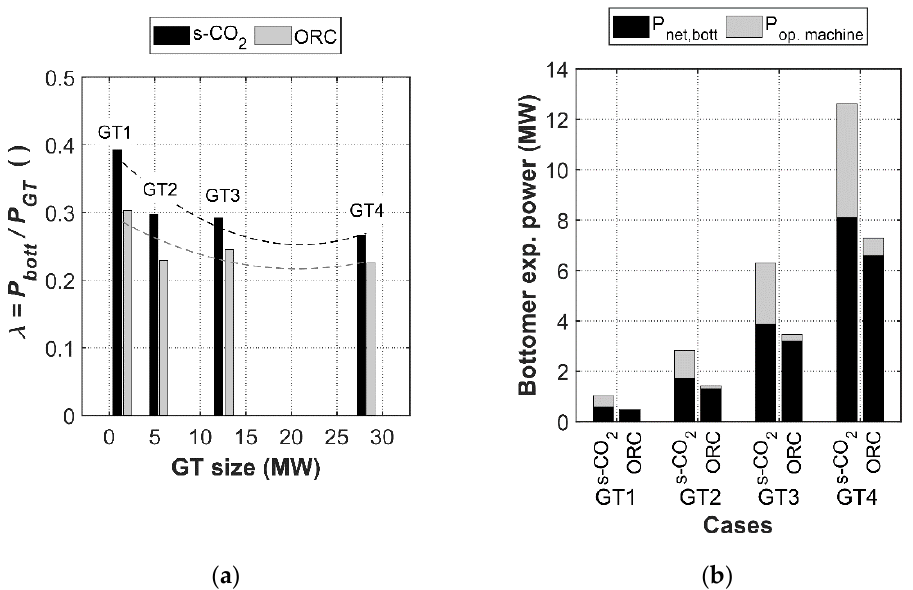
Figure 7. Bottoming cycles’ design performance: ( a ) relative and ( b ) absolute bottoming power pro- duction.